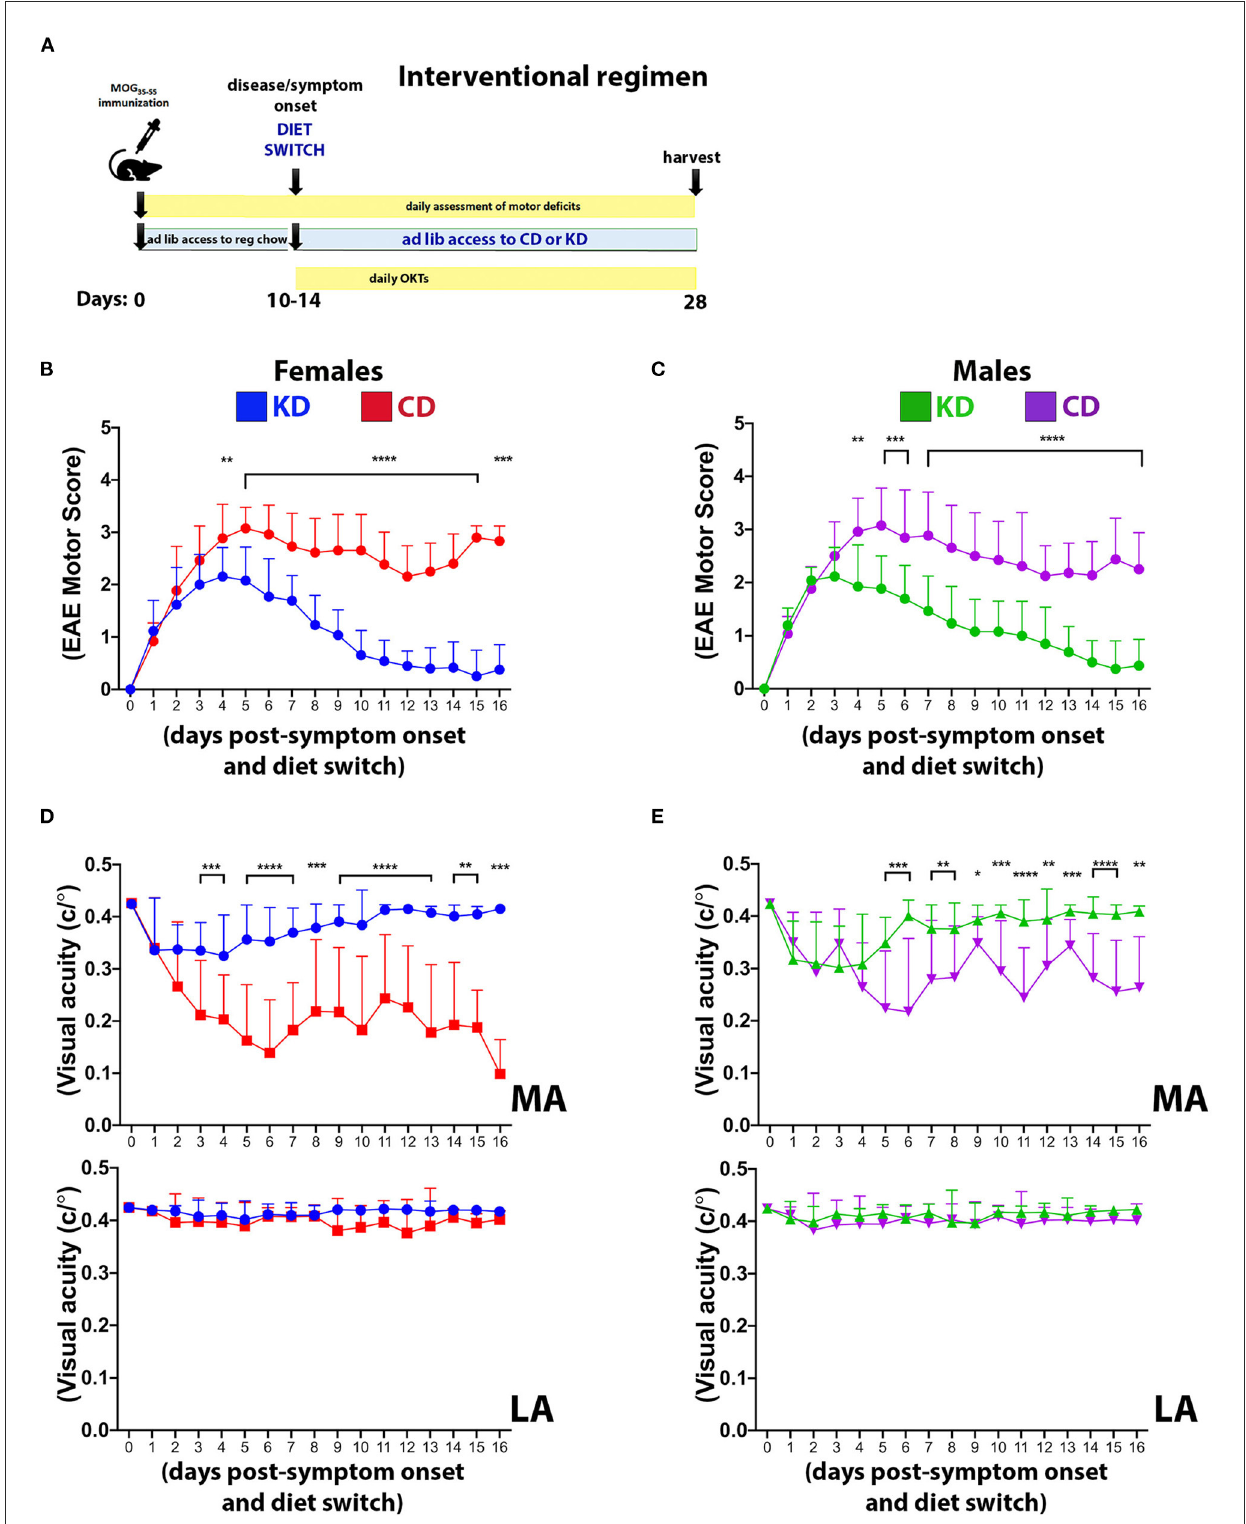
FIGURE7 The KD restores motor and visual function to EAE mice when fed following symptom onset. (A) Diagram of the interventional regimen. Mice were immunized with MOG 35 − 55 (day 0), switched to either KD or CD diets following symptom onset (10–14 dpi), and maintained on the respective diets for the duration of the experiment (28 dpi). Motor scores and visual acuity were tracked as indicated. Daily motor scores of female (B) and male mice (C) switched to the indicated diets following the onset of motor and visual deficits. Blue and green traces show female and male mice on KD, respectively, with red and purple traces showing female and male mice on CD, respectively. n = 13 mice/sex/diet. (D) OKT measurements of visual acuity of the more affected (MA; top graph) and less affected (LA; bottom graph) eyes in female mice on the indicated diets. n = 13 mice/diet. (E) Same as (D) for male mice. n = 13 mice/diet. All data graphed with the x -axis representing “days post-symptom onset and diet switch”. N.B.: DAY 0 is the day before symptom onset and is denoted by a motor score of zero. Asterisks in all graphs denote statistical significance: * p < 0.05, ** p < 0.01, *** p < 0.001, **** p < 0.0001. Data compiled ≥ 4 independent